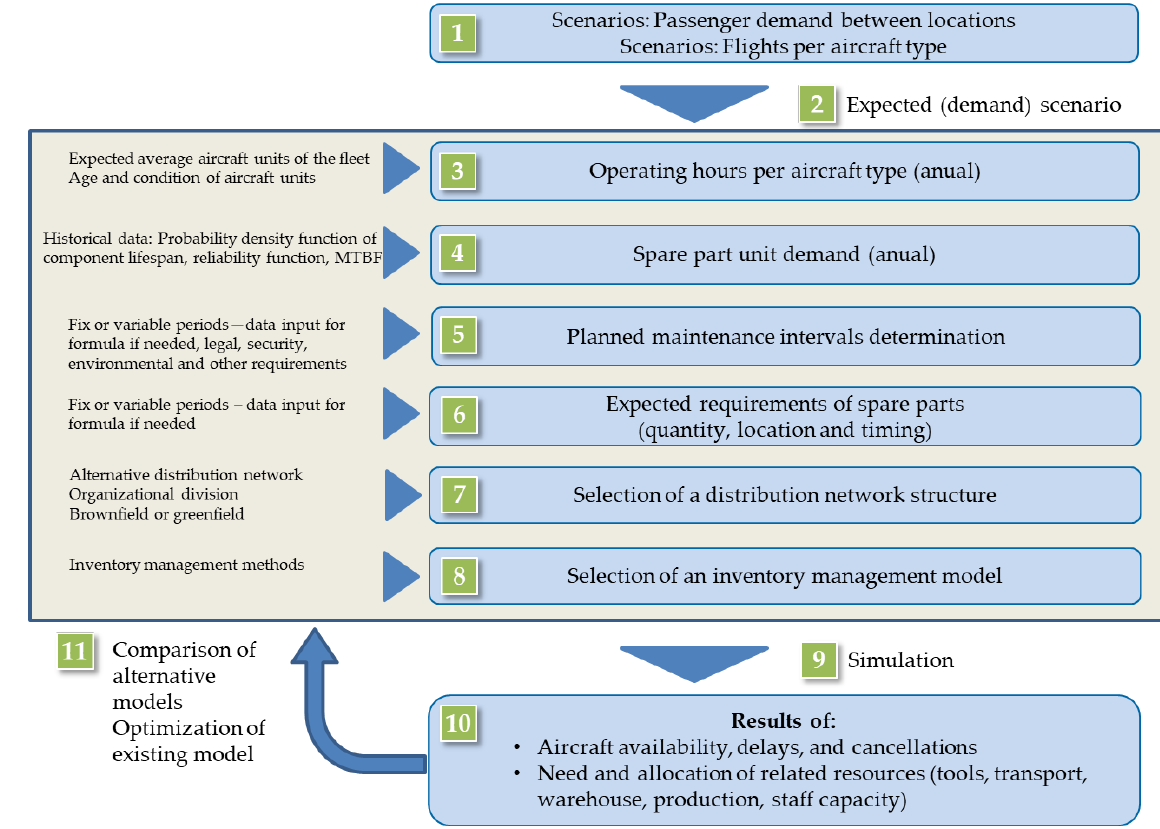
Figure 11. Managerial implications—methodology and steps (own elaboration). Based on the methodology applied for all spare parts components, thedecisions outlined in Figure 12 can be analyzed.